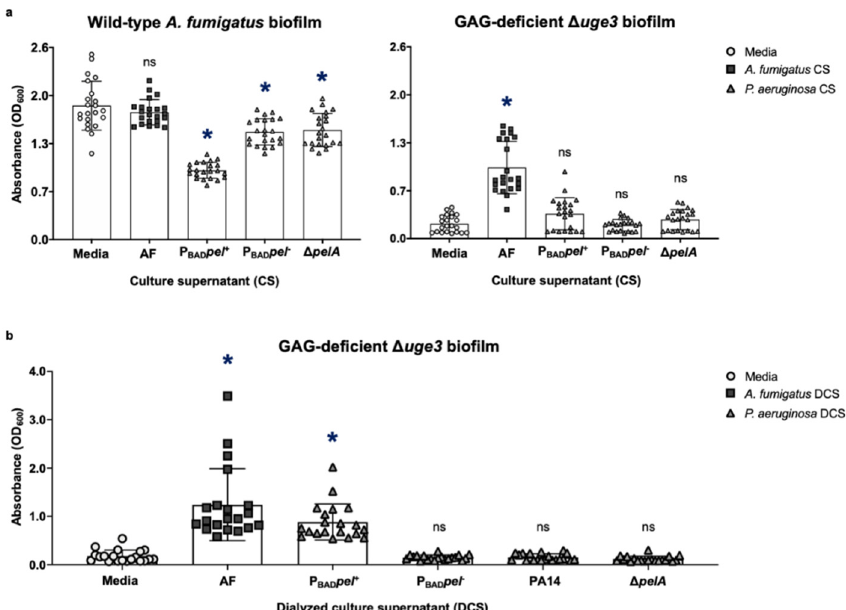
Figure 8. Inhibitory effects on the growth of A. fumigatus by secreted products within P. aeruginosa culture supernatants that dominate over the augmentation of A. fumigatus -adherent biofilm formation by secreted Pel. Adherent biofilm formation by ( a ) wild-type A. fumigatus (AF) (left) and GAG- deficient A. fumigatus hyphae ( ∆ uge3 ) (right) grown in the presence of culture supernatants (CS) from wild-type A. fumigatus (AF), Pel-overexpressing ∆ wspF ∆ psl P BAD pel P. aeruginosa (P BAD pel + ), Pel-nonexpressing ∆ wspF ∆ psl P BAD pel P. aeruginosa (P BAD pel - ), or Pel-deficient P. aeruginosa ( ∆ pelA ). ( b ) GAG-deficient A. fumigatus hyphae ( ∆ uge3 ) grown in the presence of dialyzed culture super- natants (DCS) from wild-type A. fumigatus (AF), Pel-overexpressing ∆ wspF ∆ psl P BAD pel P. aeruginosa (P BAD pel + ), Pel-nonexpressing ∆ wspF ∆ psl P BAD pel P. aeruginosa (P BAD pel − ), wild-type